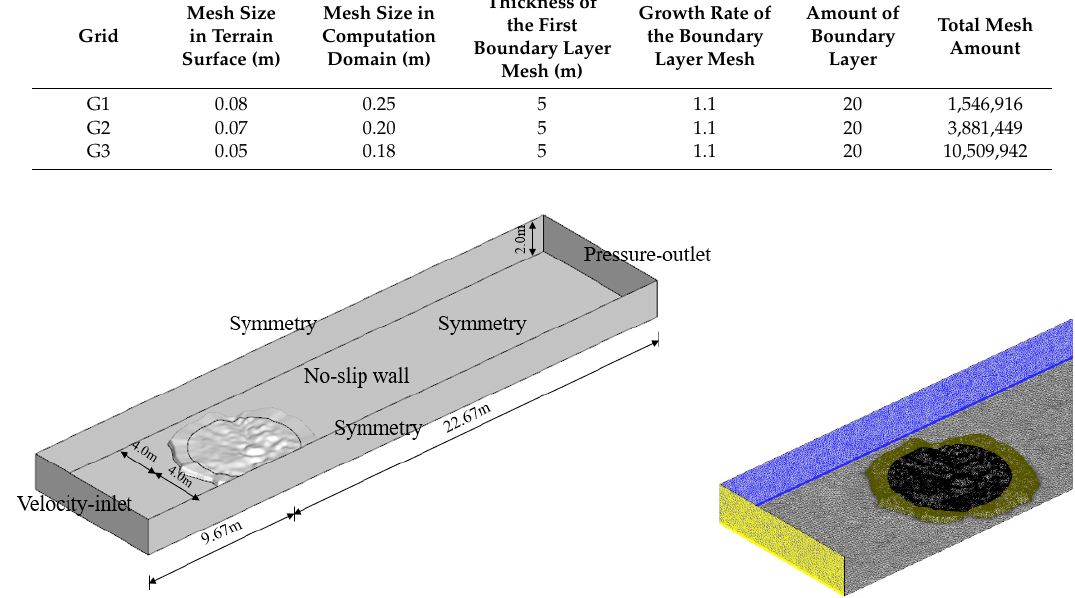
Figure 5. Computational domain, boundary conditions and grid of terrain model with BTS.